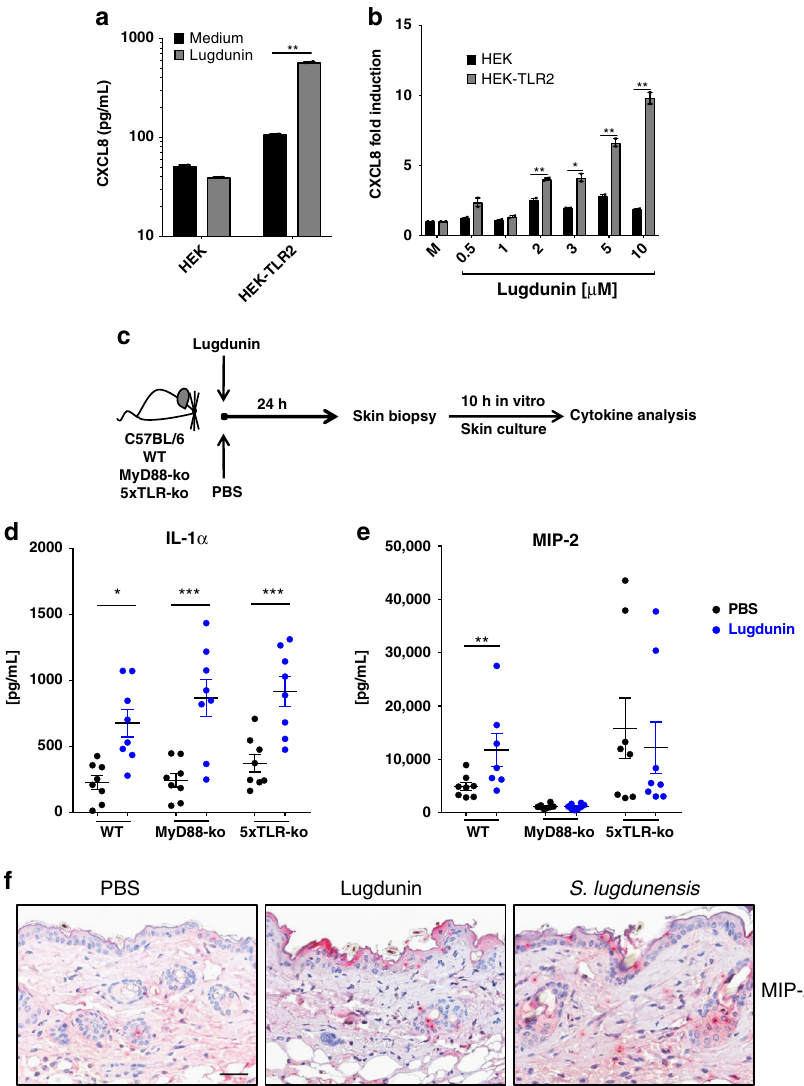
Fig. 2 Induction of chemokine (C-X-C motif) ligand 8/macrophage in fl ammatory protein-2 (CXCL8/MIP-2) by lugdunin is TLR2/MyD88-dependent. a HEK-control or HEK-TLR2 cells were treated with 2 μ M lugdunin for 5 h and subsequently the CXCL8 concentration in the supernatant was analyzed by LEGENDplex TM (BioLegend). Shown is one representative experiment of three independent experiments with two technical replicates ± s.e.m. b HEK- control or HEK-TLR2 cells were treated with increasing concentrations of lugdunin for 5 h and subsequently expression of CXCL8 was analyzed and normalized to actin. Shown is one representative experiment of three independent experiments with two technical replicates ± s.e.m. c Schematic overview of the mouse experiments: 6 – 8-week-old female C5BL/6 WT, MyD88-knockout (ko), or 5xTLR-ko mice were epicutaneously treated with 1.5 µ g lugdunin or phosphate-buffered saline (PBS) as a control. After 24 h, mice were euthanized, 4 mm skin punches were taken, and further cultured in vitro for 10 h followed by cytokine analysis of the culture supernatant by LEGENDplex TM (BioLegend). d , e Shown are the mean concentrations of IL-1 α ( d ) or